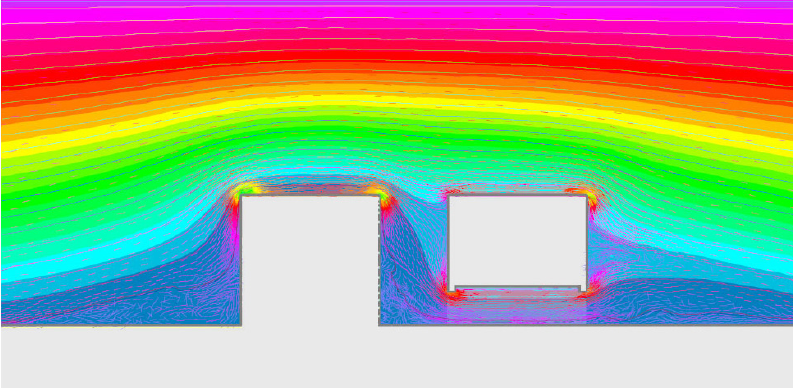
Figure 12. Streamlines. Courtyard of depth ratio D = 3 with entrance hall